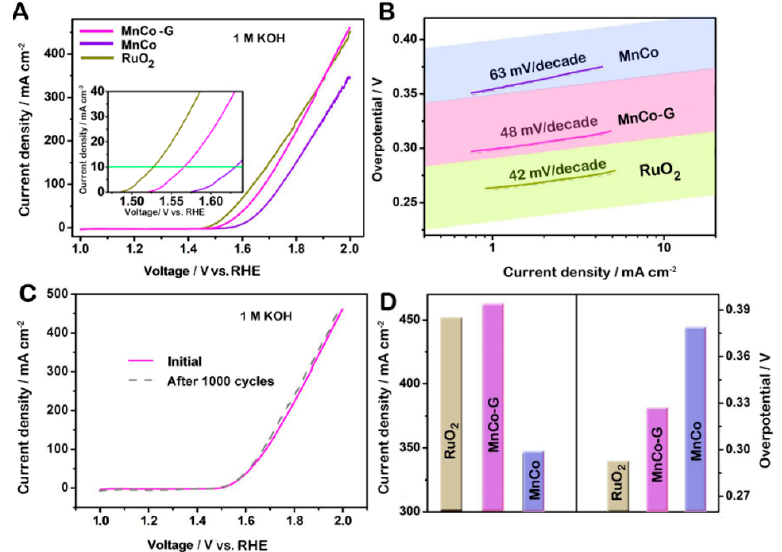
Figure 4. ( A ) Linear sweep voltammetry (LSV) curves of the catalysts; ( B ) Corresponding Tafel slopes; ( C ) LSV curves after 1000 CV cycles for the MnCo-G electrode; ( D ) comparison of current achieved at the potential of 2.0 V vs. reversible hydrogen electrode (RHE) and overpotential for 10 mA cm − 2 . All tests were conducted in 1.0 M KOH.